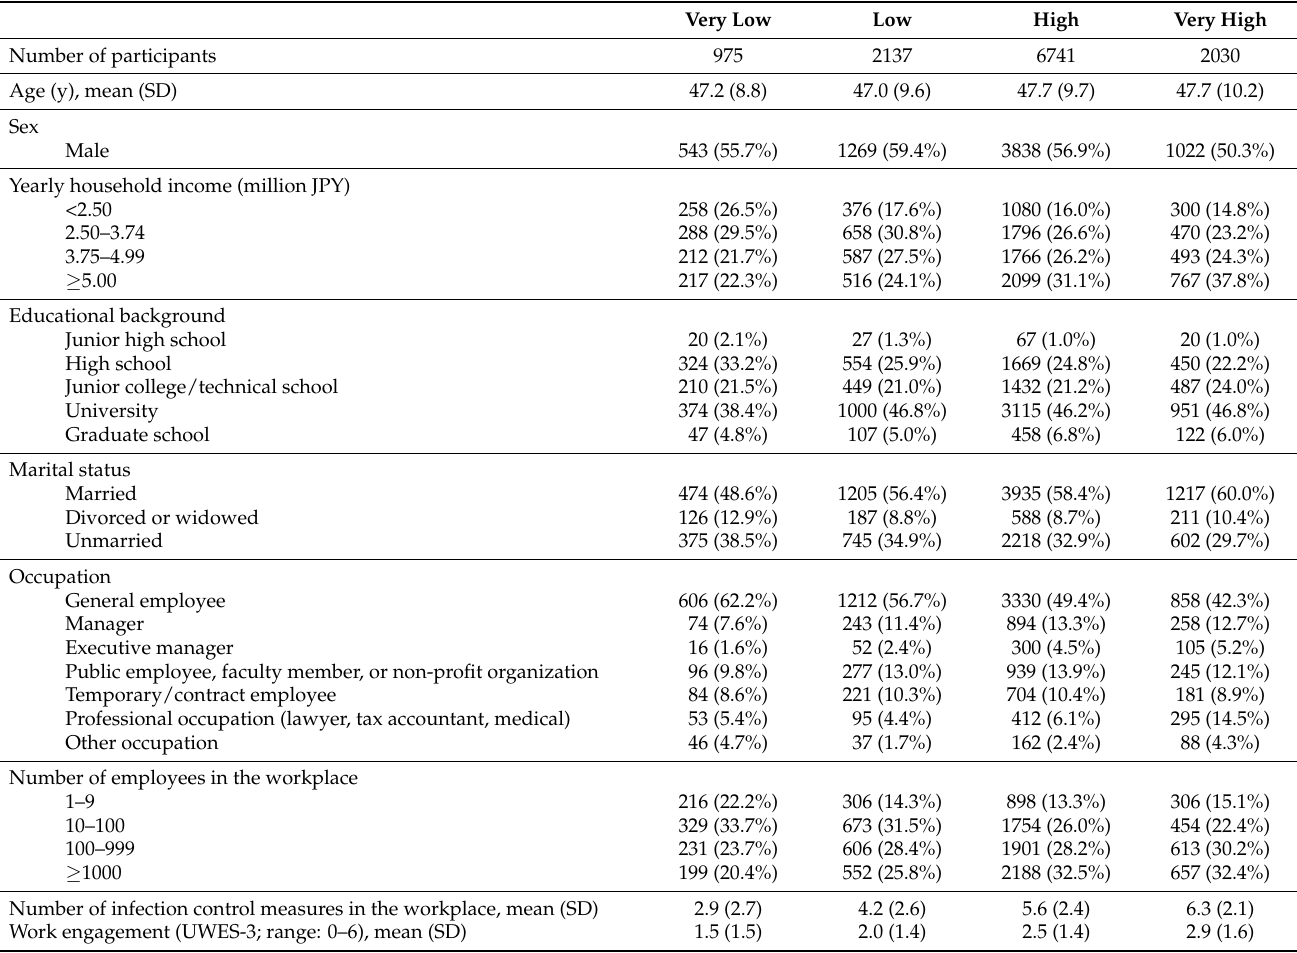
Table 1. Characteristics of participants by POS-IP category at baseline. Very Low Low